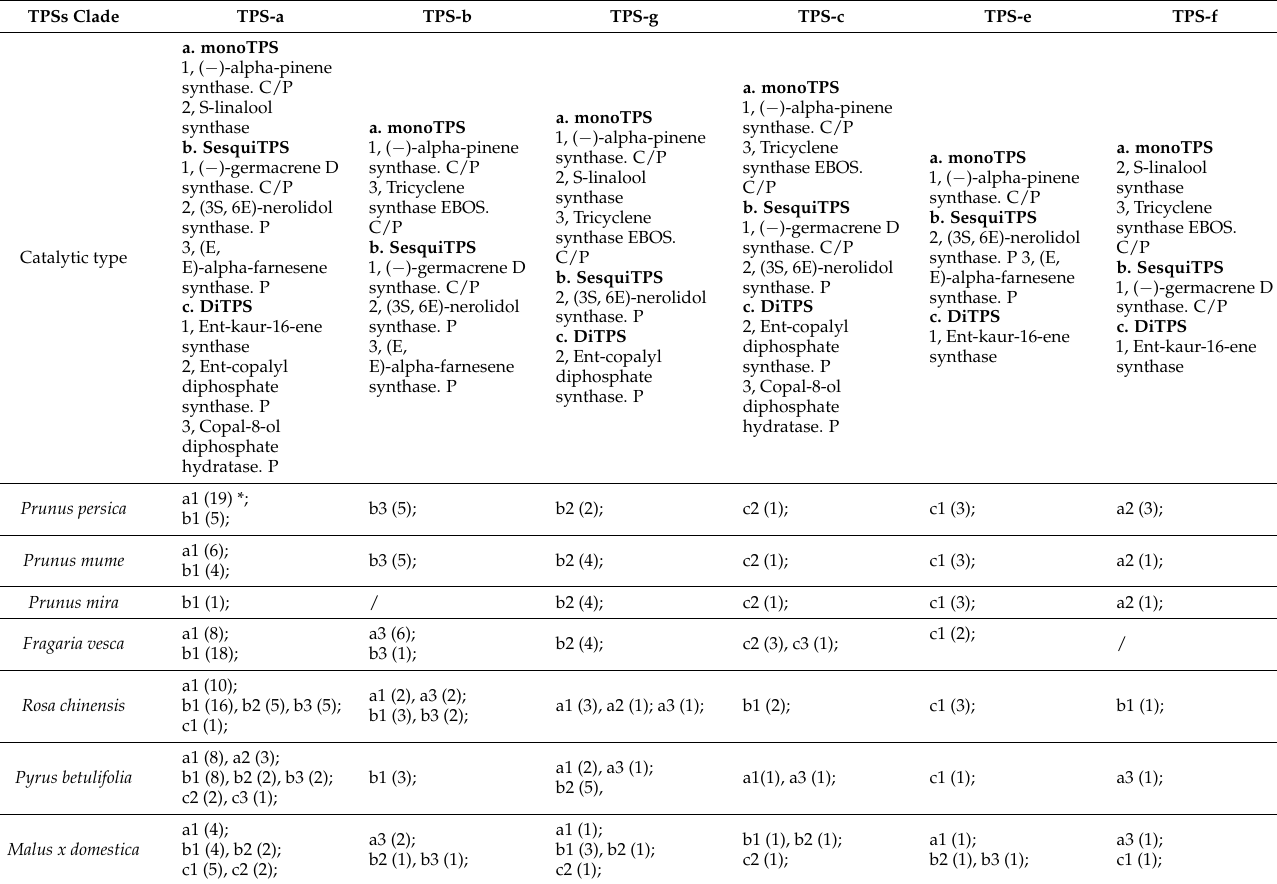
Table 3. Putative functions of TPSs in six Rosaceae